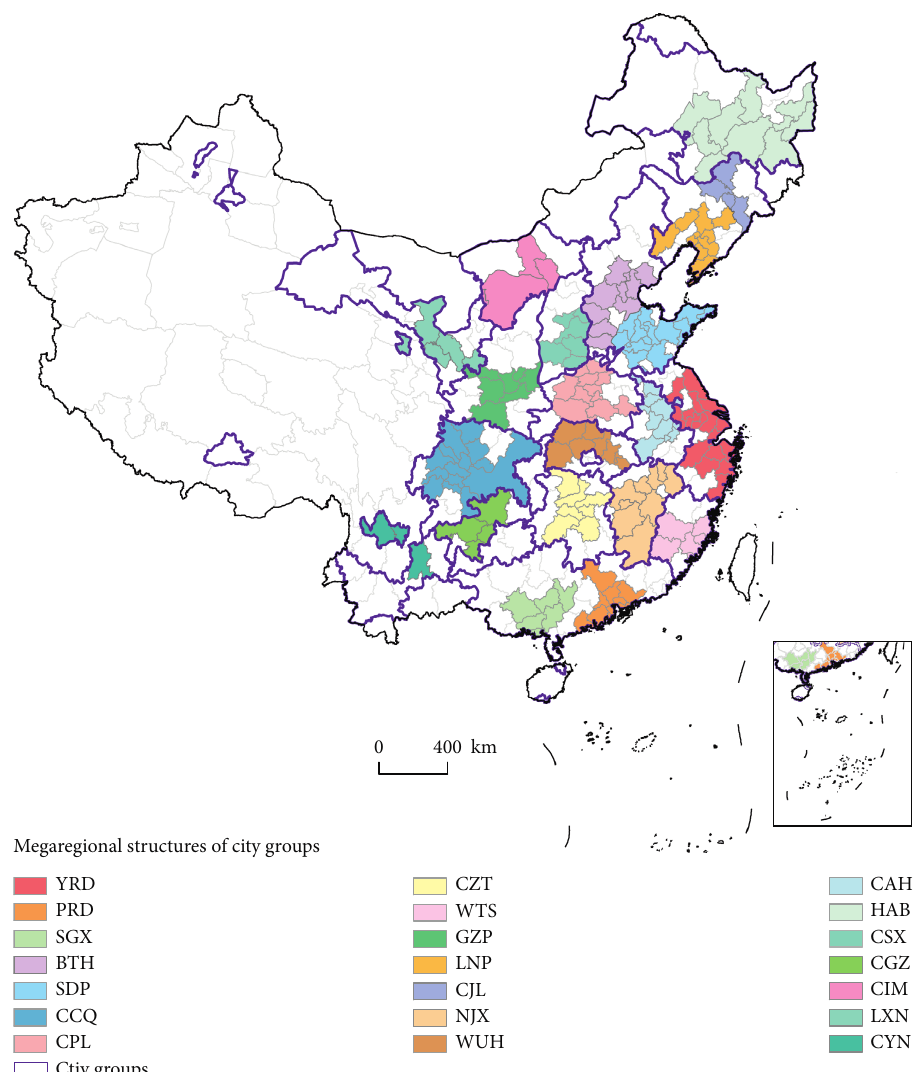
Figure 6: Megaregional structures of city groups in